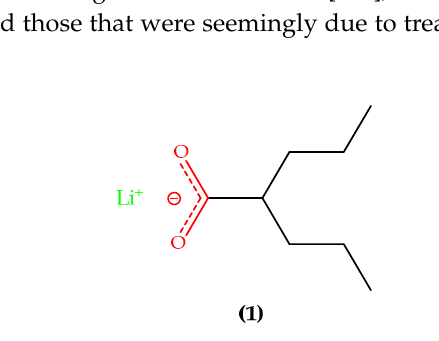
Figure 3. Chemical structure of lithium ion coordinated to valproic acid ( 1 ) (as valproate).